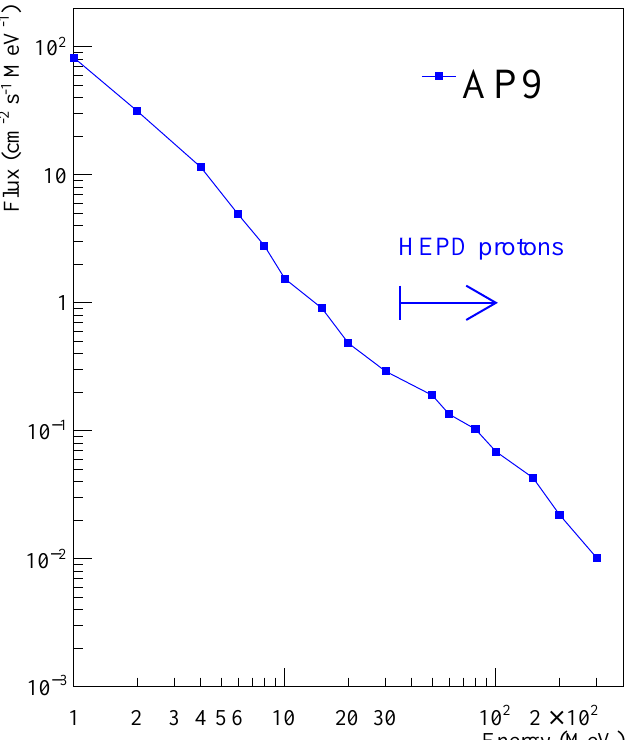
Figure 1. Omnidirectional differential spectrum of trapped protons (blue squares) as a function of kinetic energy, obtained from the AP9 model and averaged over all the orbits of the testing day—1 January 2021. HEPD low-energy threshold for protons (30 MeV) is also depicted as a blue arrow. The AP9 model could also be very useful to help define a fiducial area on the Earth’s surface (longitude vs. latitude) that may be applied to the future HEPD data analysis of trapped particles. However, the geographical extension of the inner belt (and consequently of the SAA) is largely dependent on energy, as shown in Figure 2. The surface contours for the > 1, > 10, and > 100 MeV trapped protons are depicted as red, blue, and green curves, respectively, in the panel. These contours highlight how the low-energy trapped proton component is distributed in the southern regions of the SAA-even superimposing to the outer belt, while higher energy populations are more clearly enclosed in the classical boundaries of the inner belt, i.e., in the area above Brazil and the Atlantic